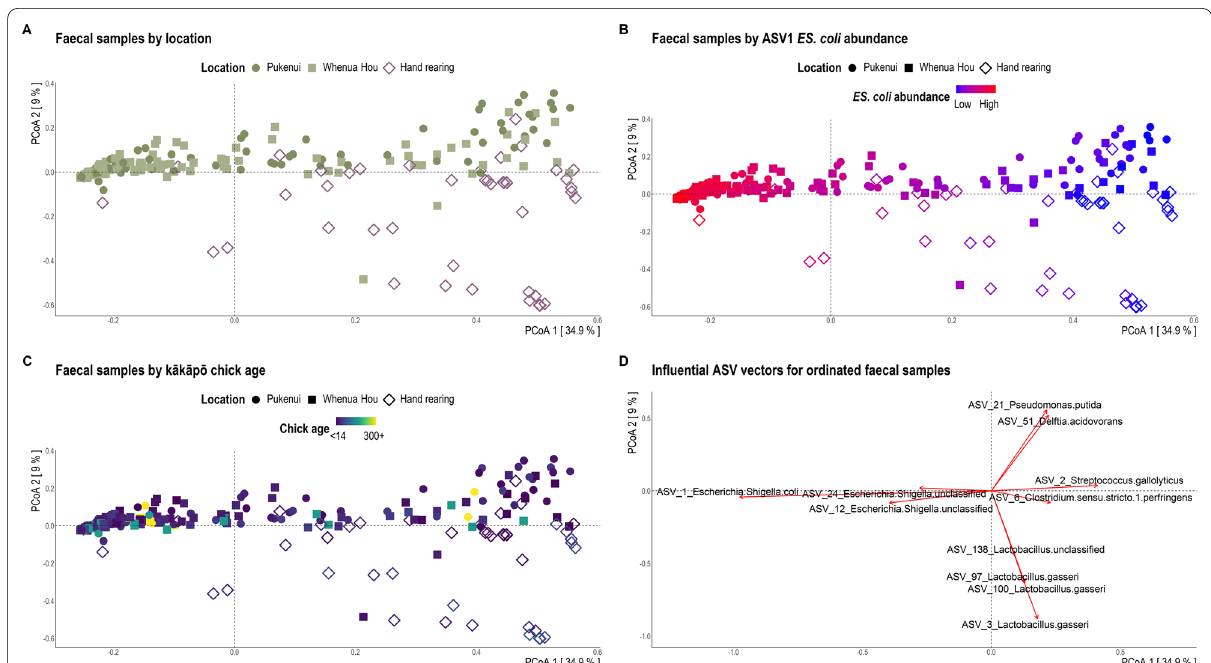
Fig. 1 Bray–Curtis dissimilarity distances based on 16S rRNA gene sequences for faecal samples visualised via principal coordinate analysis (PCoA) ordination. Each dot of the PCoA represents the microbiota of a single kākāpō chick faecal sample. Samples are shaped by location and coloured by A whether samples were collected while the chick was in the hand rearing facility versus in a nest, B relative abundance of Escherichia-Shigella coli , and C chick age at sample collection. Panel D depicts the most influential ASV vectors plotted using the vegan::envfit function